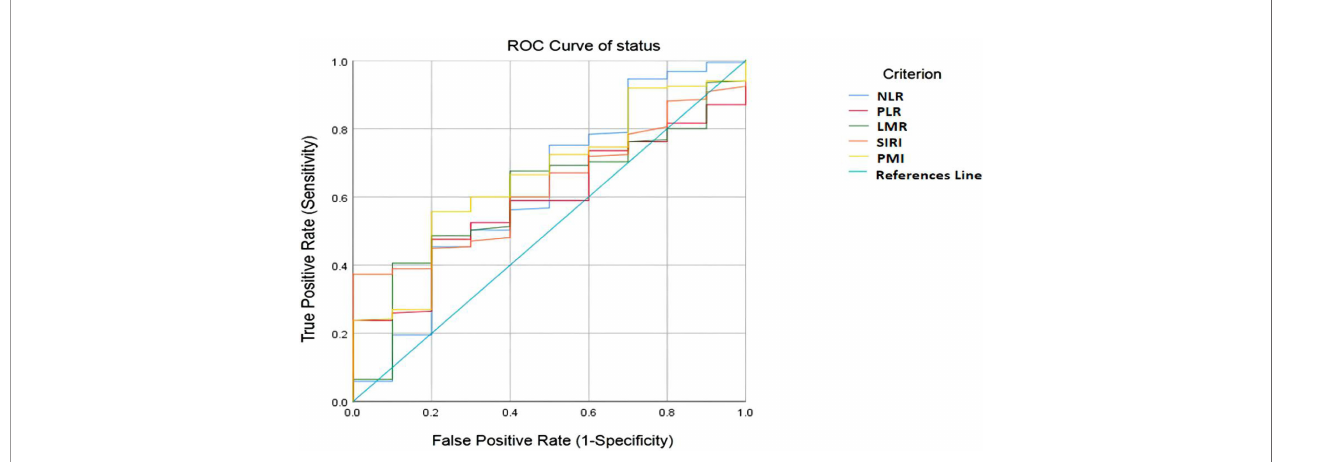
FIGURE 2 | ROC curve analysis for optimal cut-off value of NLR, PLR, LMR, SIRI and PMI. ROC, receiver operating characteristic; NLR, neutrophil-to-lymphocyte ratio; PLR, platelet-to-lymphocyte ratio; LMR, lymphocyte-to-monocyte ratio; SIRI, systemic in fl ammation response index; PMI, psoas muscle index.